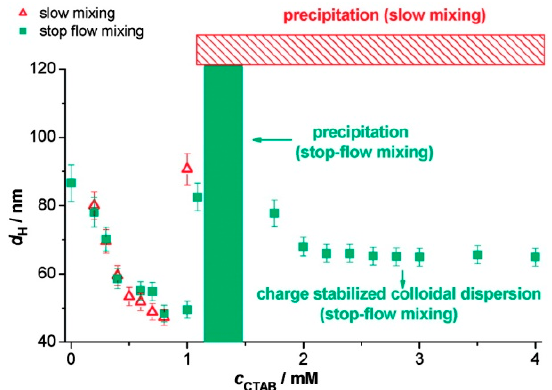
Figure 13. Effect of the applied mixing protocol on the apparent mean hydrodynamic diameter versus surfactant concentration curves, Stop-flow-mixing (green); slow-mixing (red). Reprinted with permission from Pojja ź k, K.; Bertalanits, E.; Me ź sza ź ros, R. Effect of salt on the equilibrium and nonequilibrium features of polyelectrolyte/surfactant association. Langmuir 2011 , 27 , 9139–9147, doi:10.1021/la2021353. Copyright 2011, American Chemical Society [115].